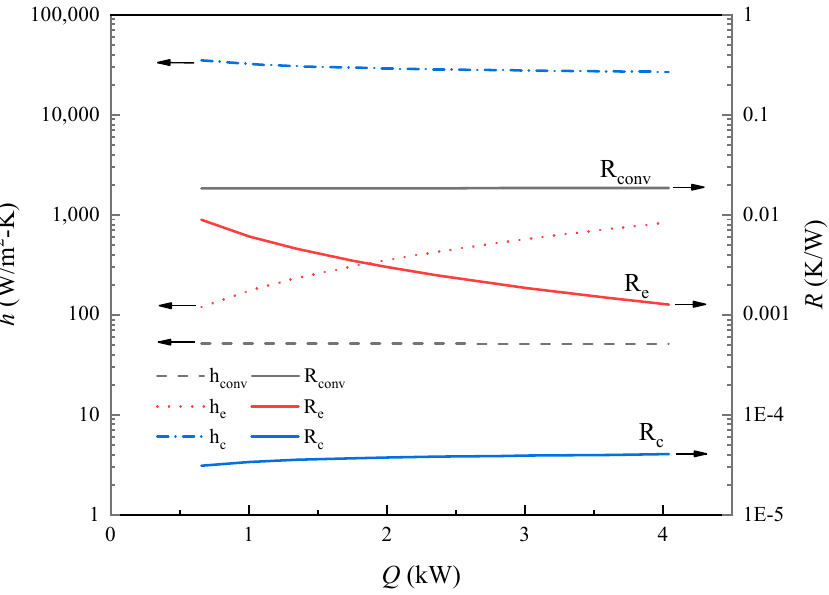
Figure 7. Decomposed theoretical thermal resistances and heat transfer coefficients under 400 CMH . Figure 8 compares the experimental and theoretical results of the total thermal re- sistances for the present study. As shown, the discrepancies between the simulations and experiments were mostly confined to within ±10%. The good agreement of the theoretical